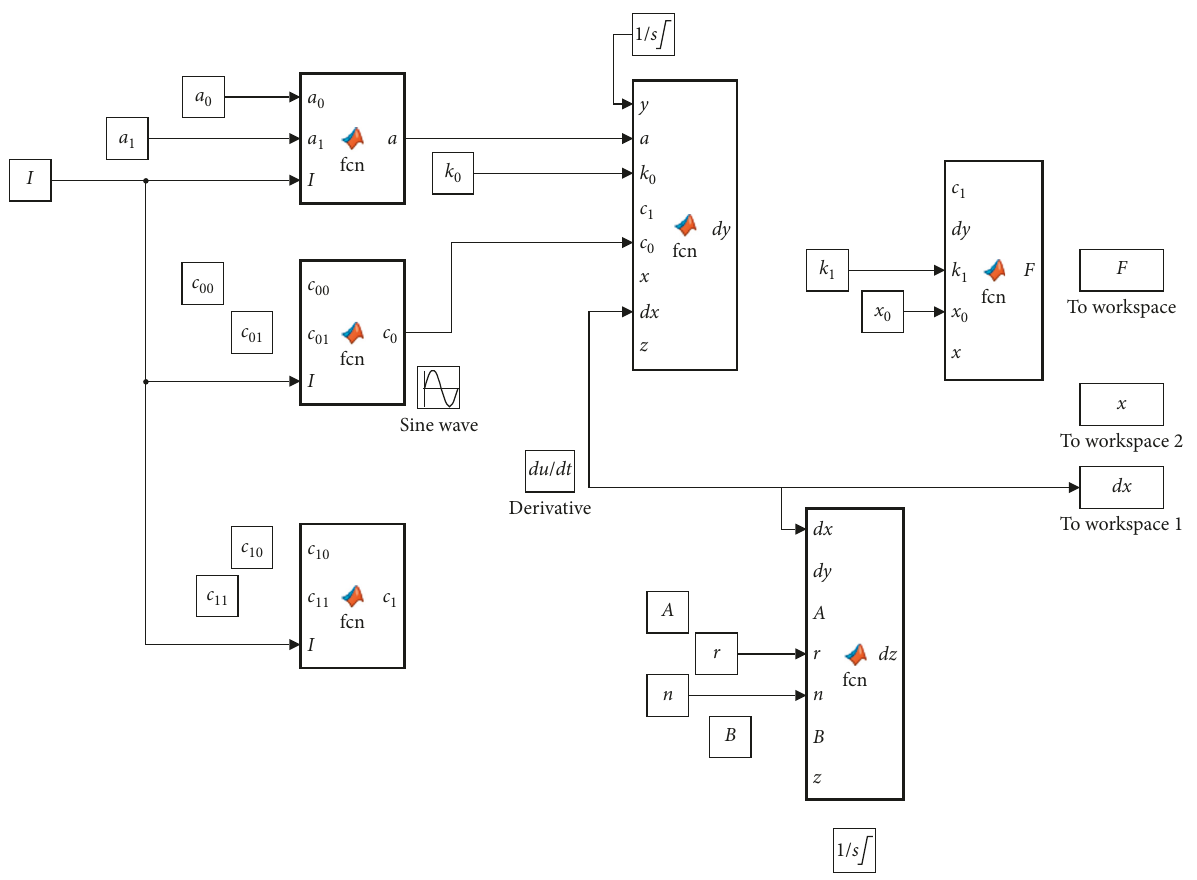
Figure 11: Phenomenon model in MATLAB/Simulink. Table 3: Phenomenon model parameters. Table 4: The average current error when Amp